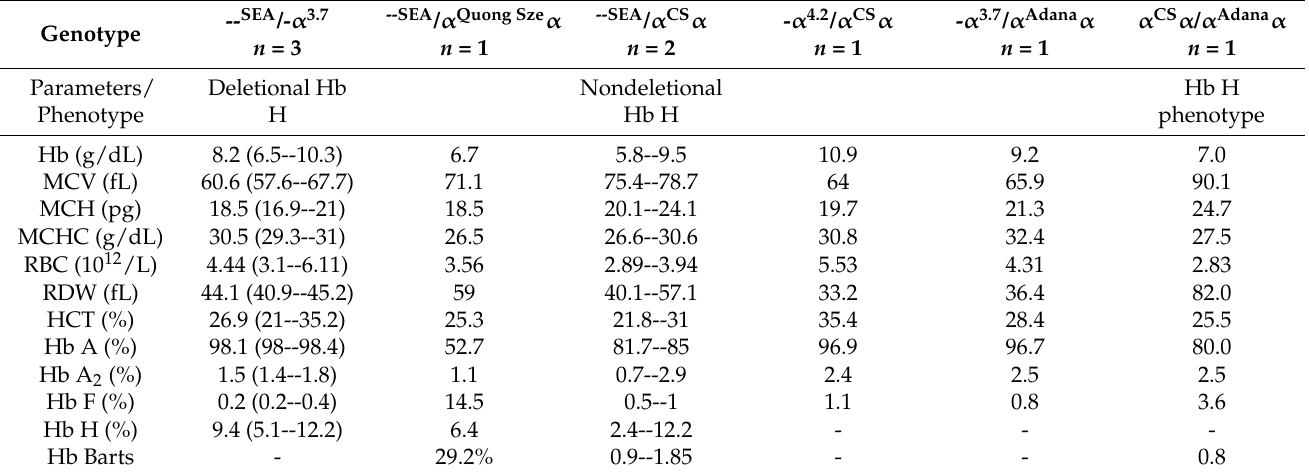
Table 4. Haematological parameters between compound heterozygous α -thalassaemia